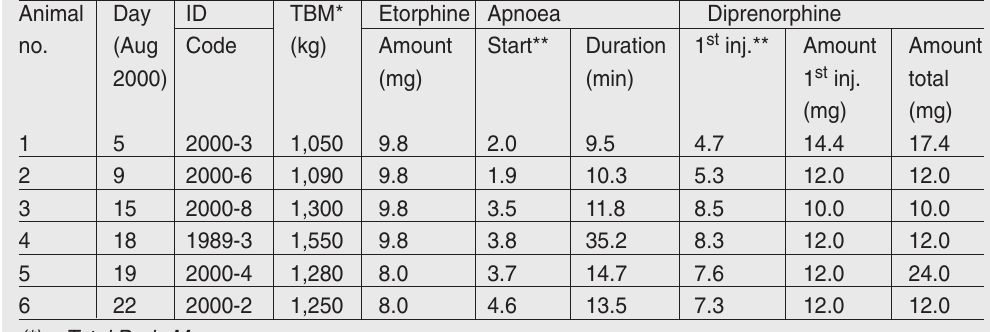
Table 1 . Data on the use of etorphine/diprenorphine for the immobilisation of six walruses that were fur- ther kept restrained by use of medetomidine/atipamezole directly after regaining full respiratory function. Animal Day ID TBM* Etorphine Apnoea Diprenorphine no.